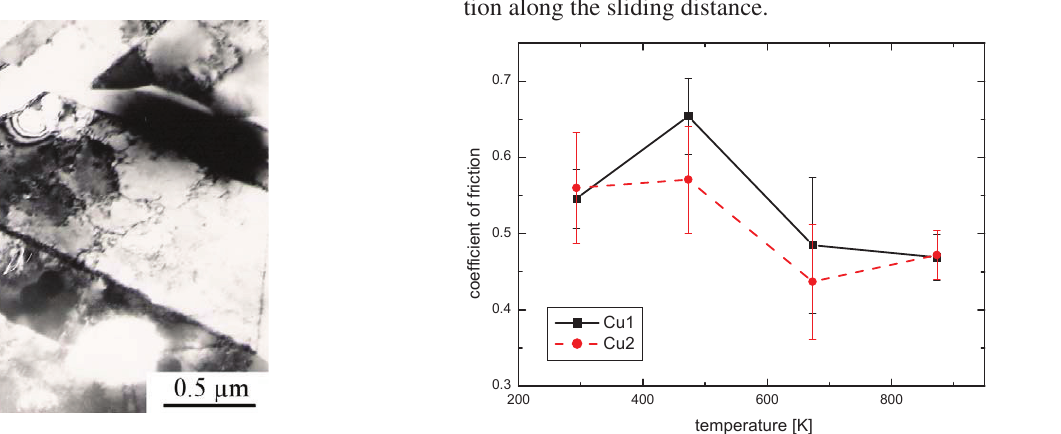
Figure 1. TEM micrograph of the micro-composite Cu1.